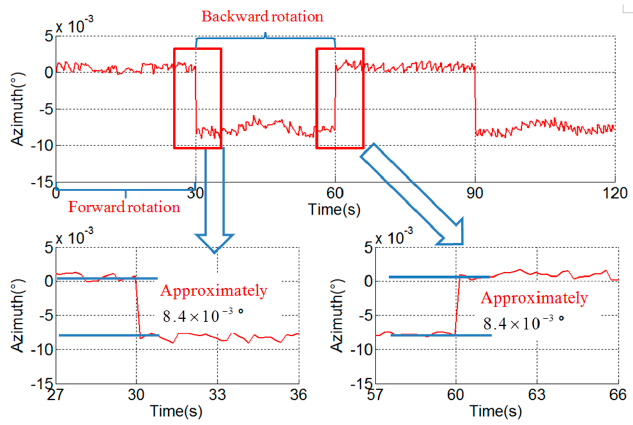
Figure 9. Stair error of azimuth ( ω = 12°/s).